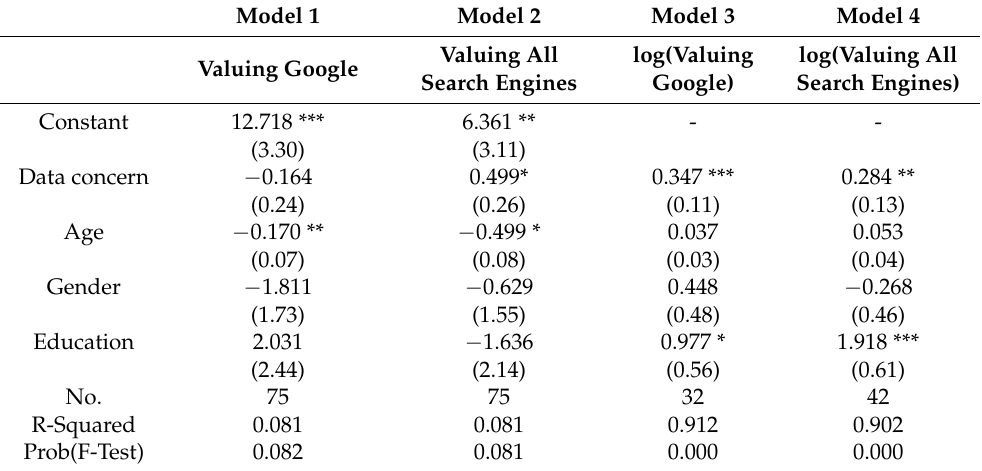
Table 3. Regression for fixed price